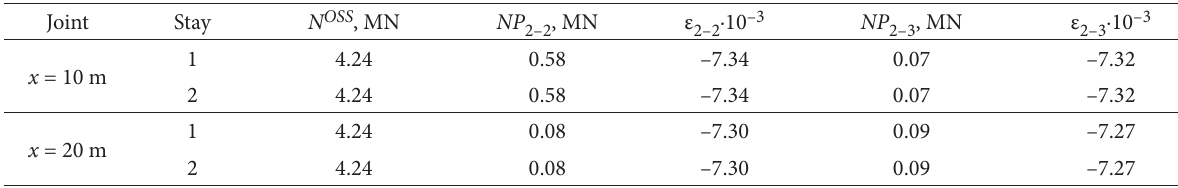
Table 1. Obtained values for bridge B 2 Joint